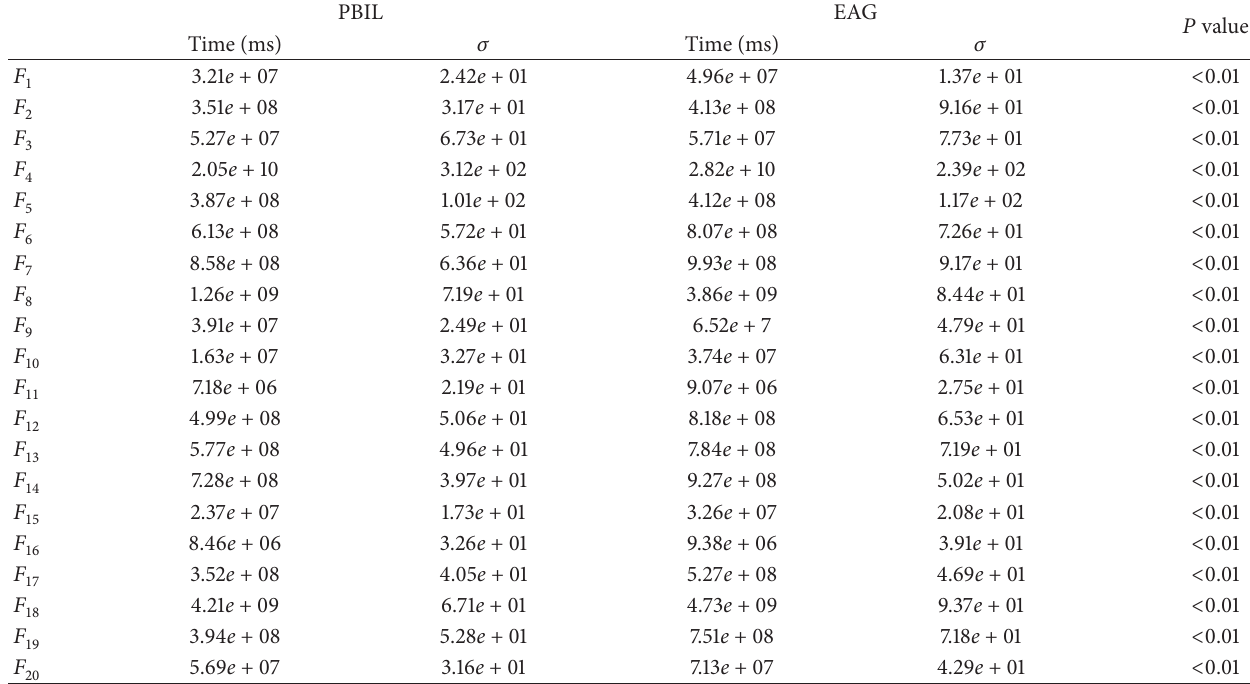
Table 4: Computational time of PBIL and EAG on CEC’2010 benchmark functions.